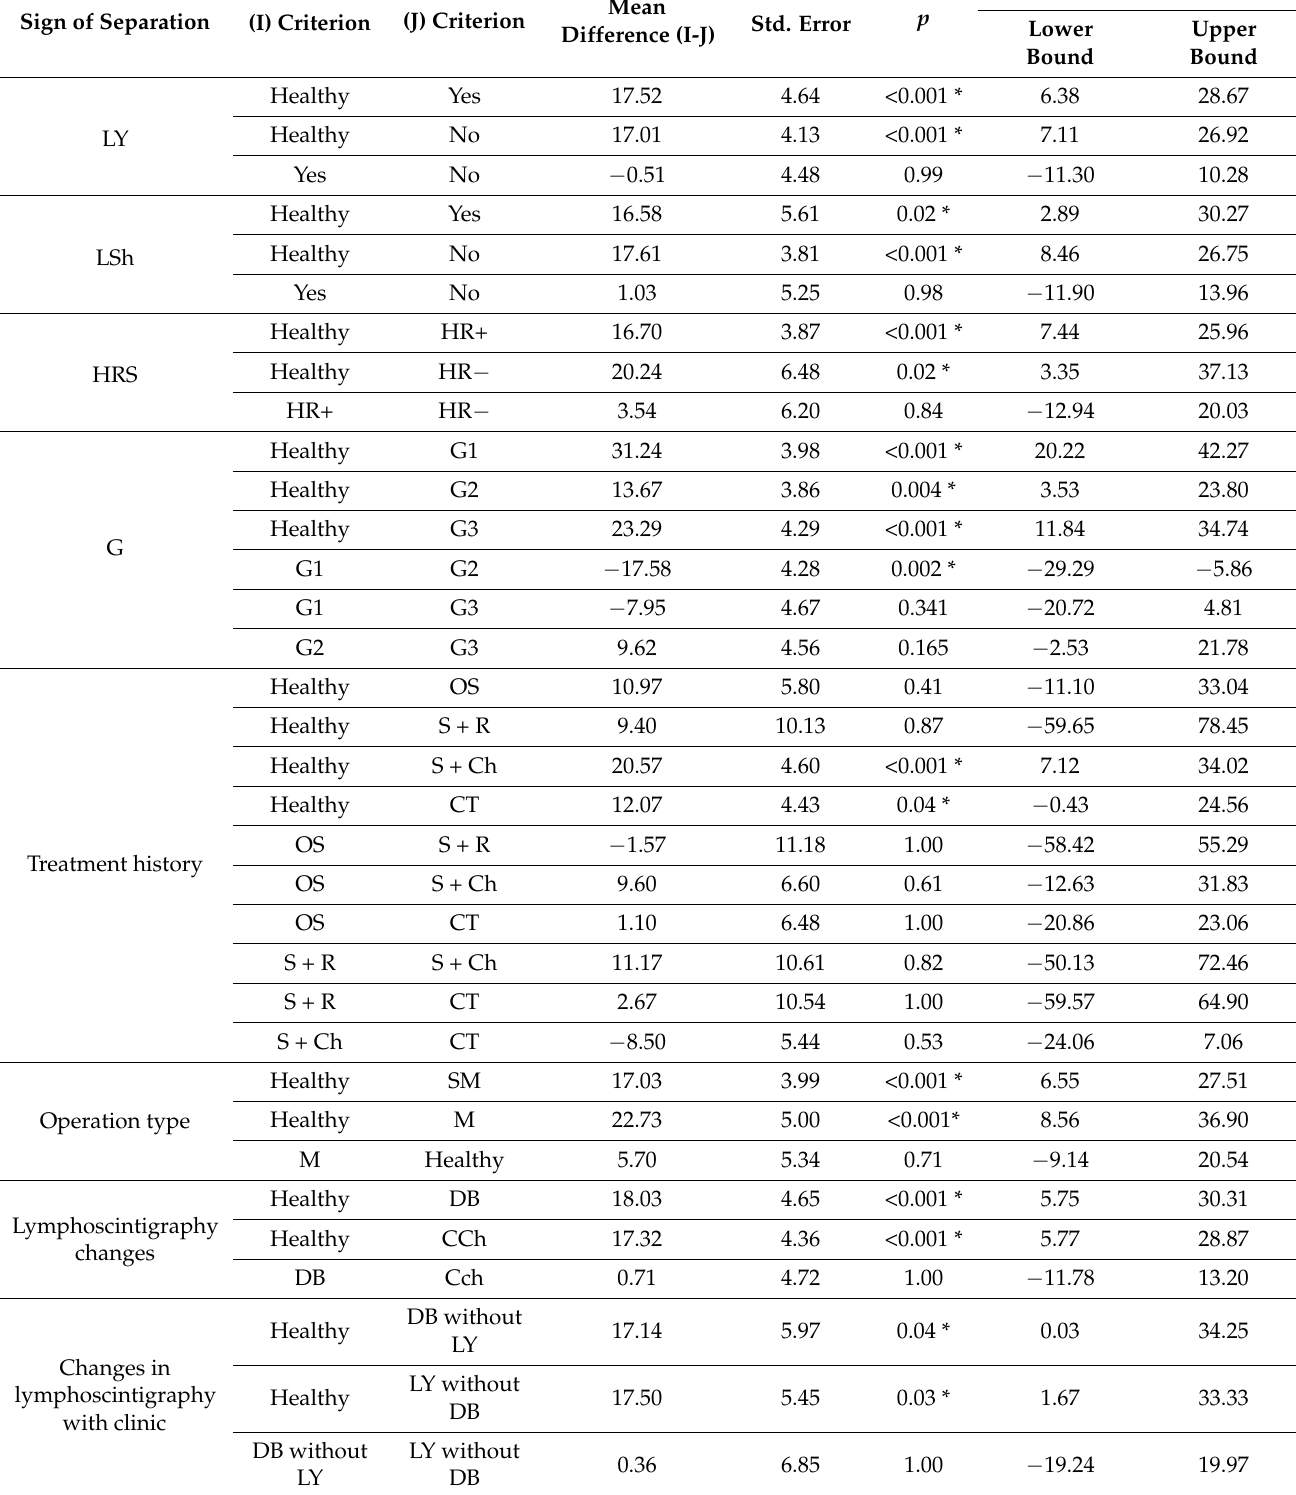
Table 7. Games–Howell test result for two groups according to TIMP-2